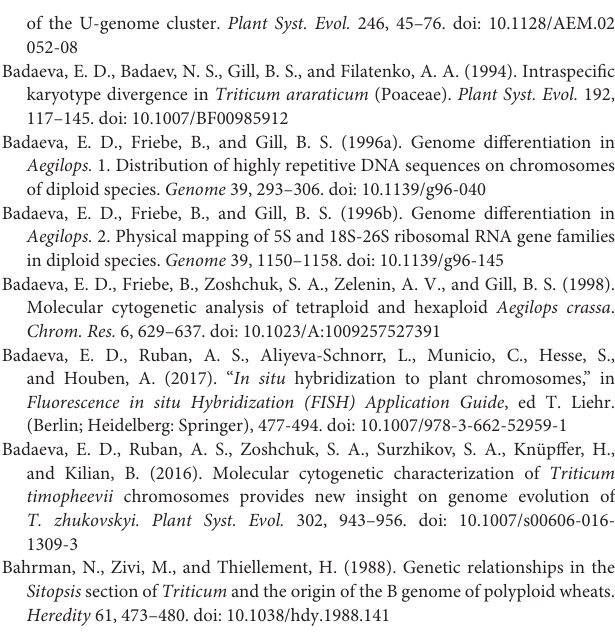
Figure S1 | Diversity of the C-banding patterns in Aegilops speltoides accessions: (a) , No1, from Turkey (provided by Dr. N. Aminov); (b–f) , genotypes collected from Israeli populations; (b,c) , C1, Technion park, Haifa; (d) , C2, Nahal Mearot; (e) , G2.46, Ramat haNadiv; (f) , C14, Keshon; (g) , no 2734 (unknown provided by Dr. B. Kilian); (h) , No 2 from Iran (provided by Dr. N. Aminov); (i) , i-570060; (j) , TS89, Katzir, Israel; (k) , PI 487233, and (l) , PI 487231 (from Syria); (m) , PI 542269 (Turkey). Arrows show unbalanced chromosome modifications. Figure S2 | Interspecific and intraspecific variation of the C-banding patterns in Ae. bicornis (a1–a3) , Ae. searsii (b1–b4) , Ae. sharonensis (c1–c8) , and Ae. longissima (d1–d10) . Accession codes: (a1) , TA1942; (a2) , TB04-3; (a3) , TB10-2; (b1) , G.7.15; (b2) , TE01-1; (b3) , G7.12; (b4) , IG 47619; (c1,c2) , C6, Keshon; (c3) , C5, Caesaria; (c4) , TH04; (c5) , TH01; (c6) , TH02; (c7) , C4, Atlit; (c8) , C7, HaBonim; (d1) , TL06; (d2) , TL01; (d3) , G6.77 (Sa’ad); (d4) , G6.58 (Tel